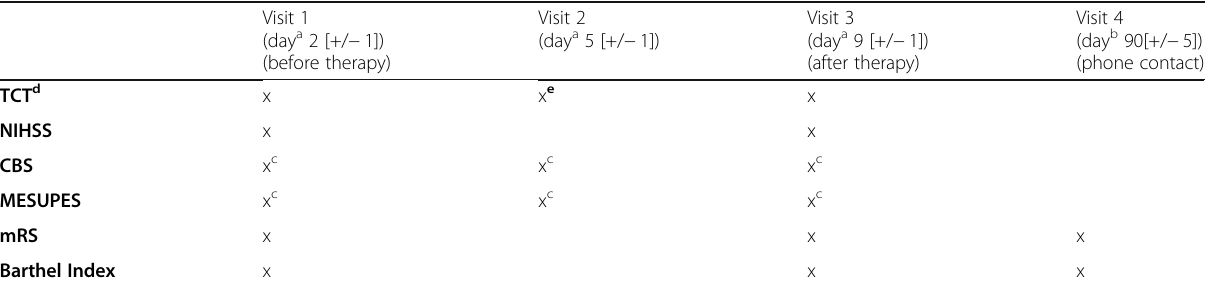
Table 1 Trial schedule on interventions and outcome